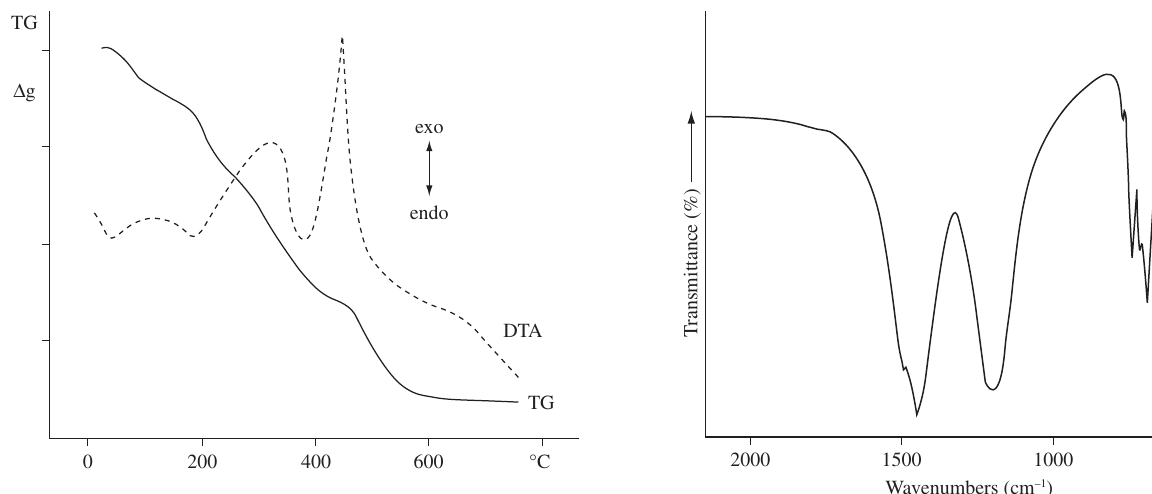
O samples, in the 2 4